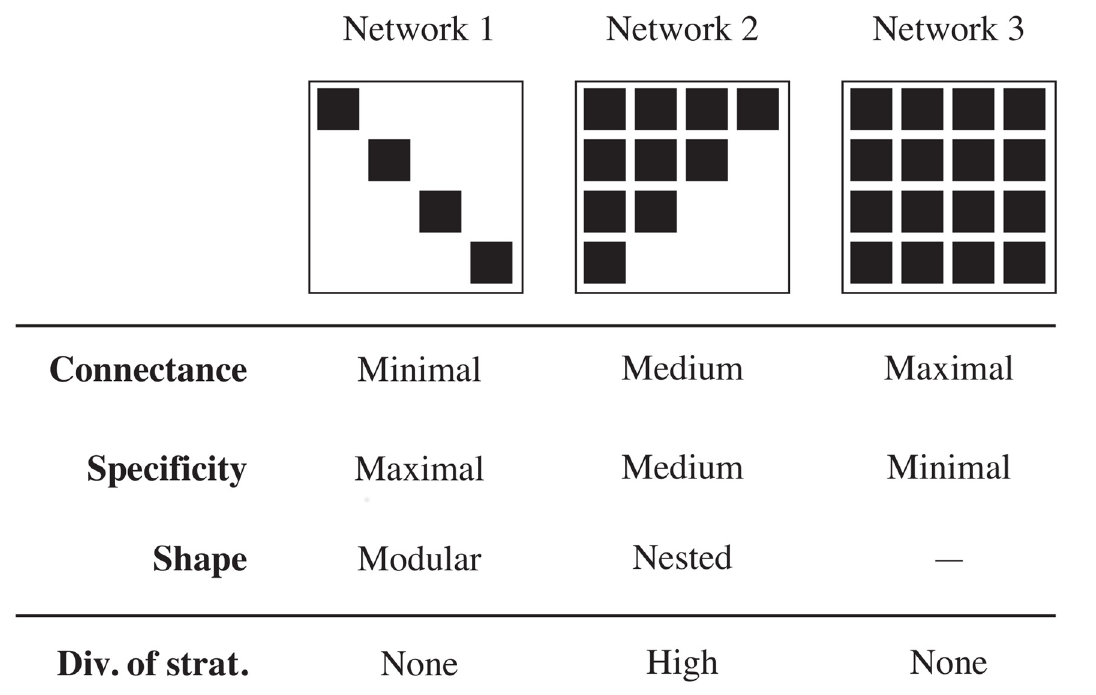
Fig 1. Expected relationships between connectance and other